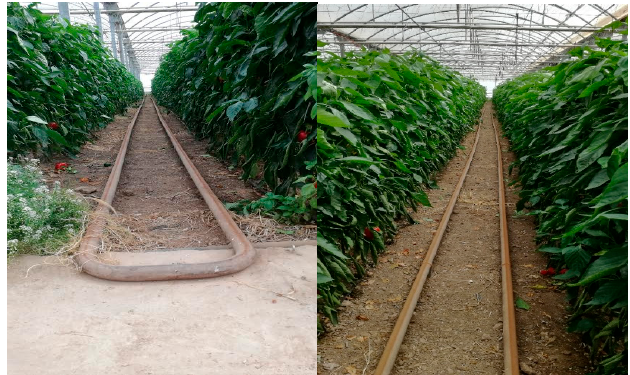
Figure 7. Steel plumbing system for distributing water vapor.